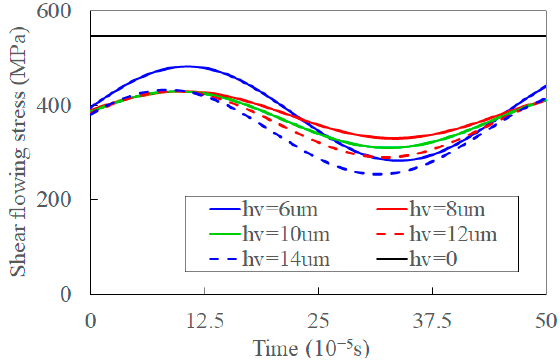
Figure 15. The shear is flowing stress with an increase of amplitude in UVC.